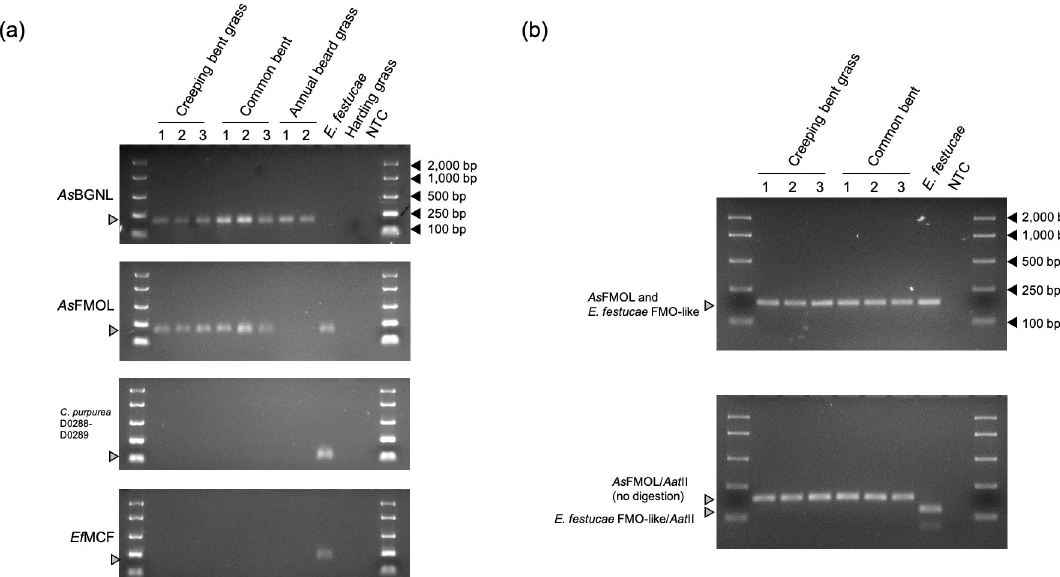
Fig 2. PCR-based screening for the HGT candidates. (a) Results of PCR amplification with the AsBGNL/LpBGNL_F and AsBGNL_R primers (top panel), and the AsFMOL_con_f1_AstII and AsFMOL_con_r1_AstII primers (second panel). As a control experiment, PCR with the C.purpurea_D0288F and R primers, and the Epichloe_mcf_F and R primers was performed (third and bottom panels). As PCR templates, gDNA samples from 3 creeping bent grass individuals, 3 common bent individuals, and 2 annual beard grass individuals were used, along with those of E . festucae and harding grass. NTC stands for ‘no template control’. The expected positions of PCR amplicons on the agarose gel are indicated with grey arrows. The BIOLINE EasyLadder I was used as size standard and the sizes of ladders are indicated with black arrows. (b) Results of the PCR-RFLP assay. The upper panel shows PCR fragments from each gDNA sample before the restriction enzyme treatment, and the lower panel shows the fragments after the treatment.